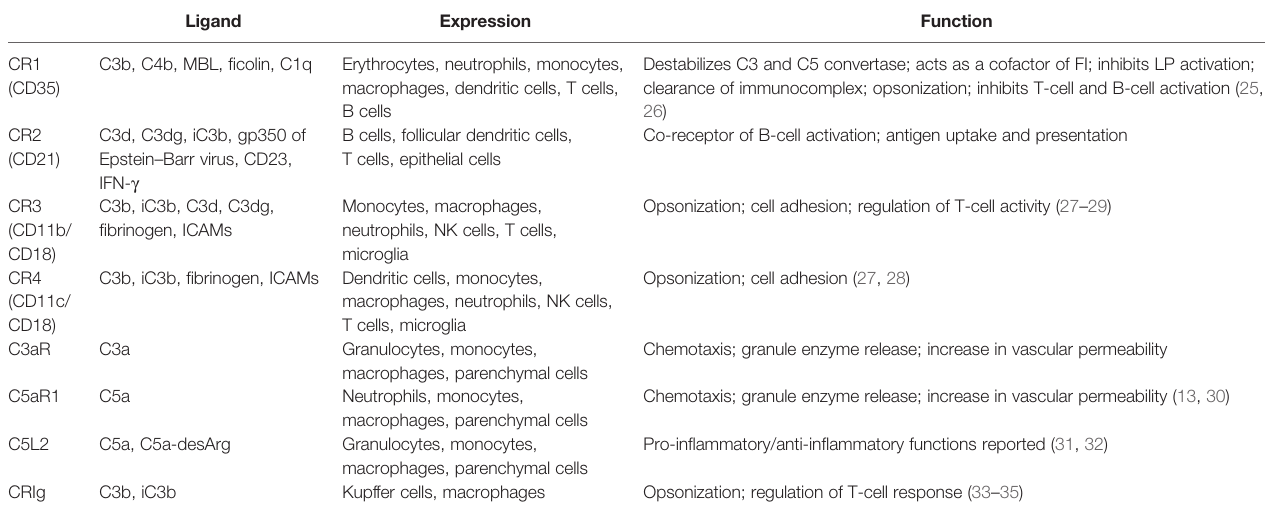
TABLE 1 | Expression and function of complement